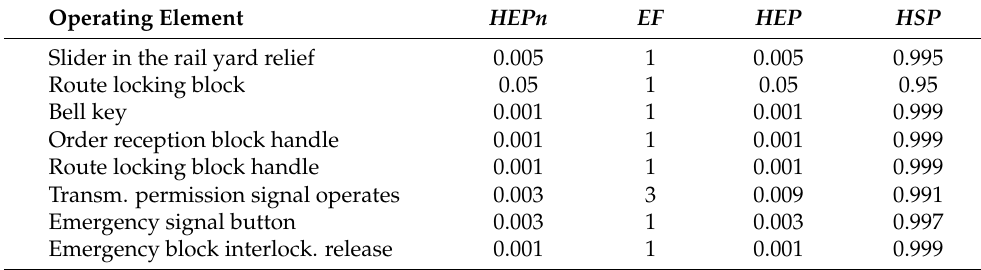
Table 10. Summary of HEP s, HSP s of operated elements (workplace A).